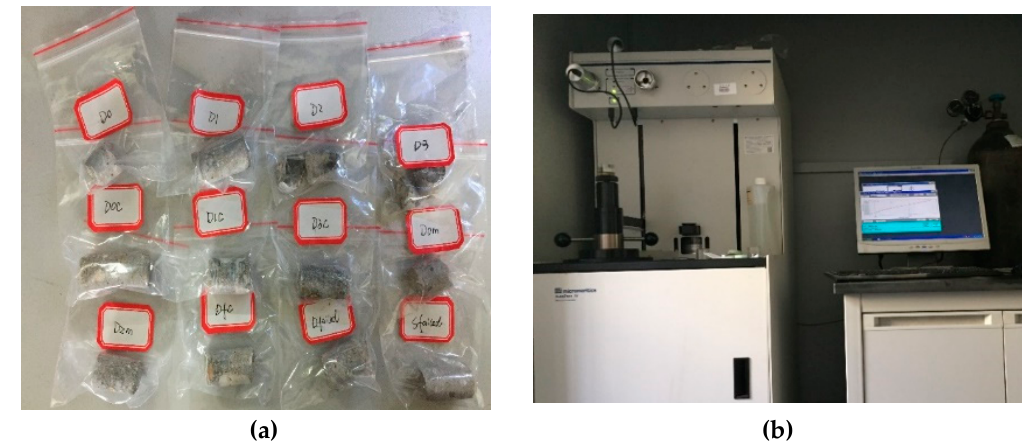
Figure 3. Mercury intrusion test of fatigue-damaged concrete: ( a ) cylindrical sample and ( b ) mercury intrusion meter.